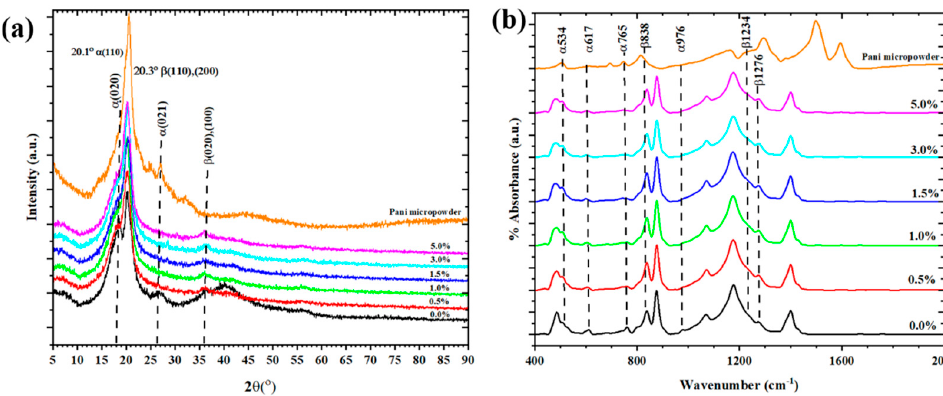
Figure 5. ( a ) XRD patterns and ( b ) FTIR spectra of pure P(VDF-HFP) and P(VDF-HFP)/PANI composite nanofibers with different PANI concentrations (0, 0.5, 1.0,1.5, 3.0 and 5.0 wt%). Table 2. Evaluated crystallinity and β -phase fraction in the samples.